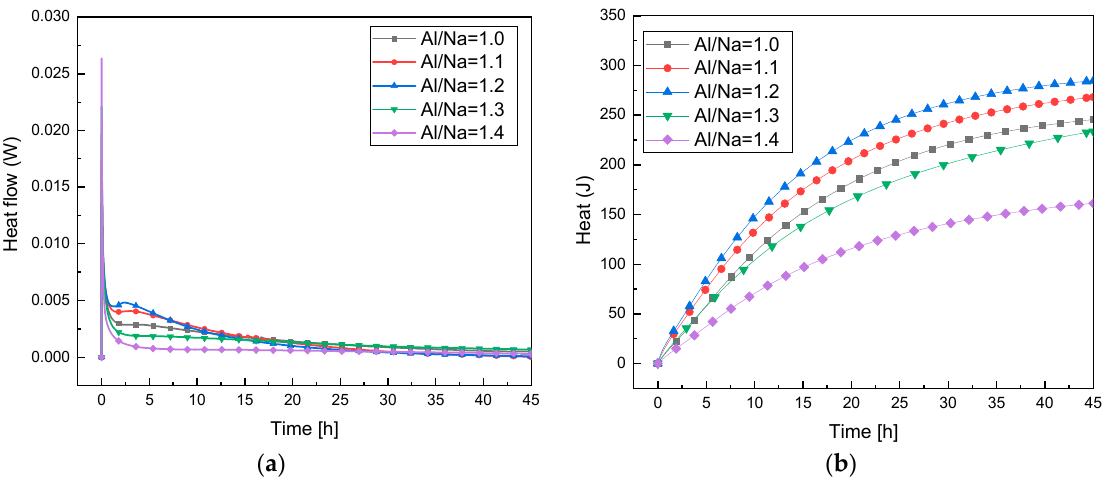
Figure 6. ( a ) The exothermic reaction rates at different Al/Na ratios; ( b ) the total exothermic reaction map at different Al/Na ratios.